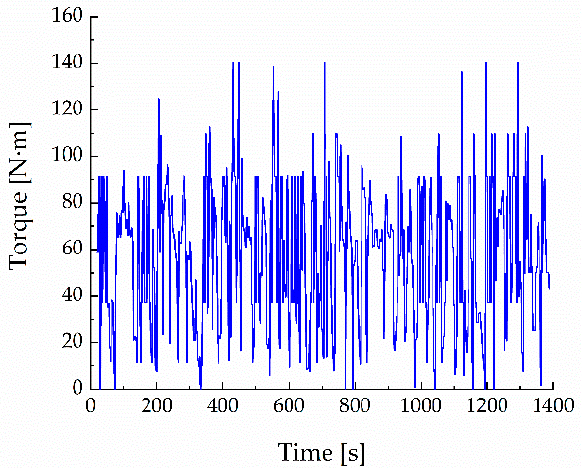
Figure 8. Friction braking torque–time history.